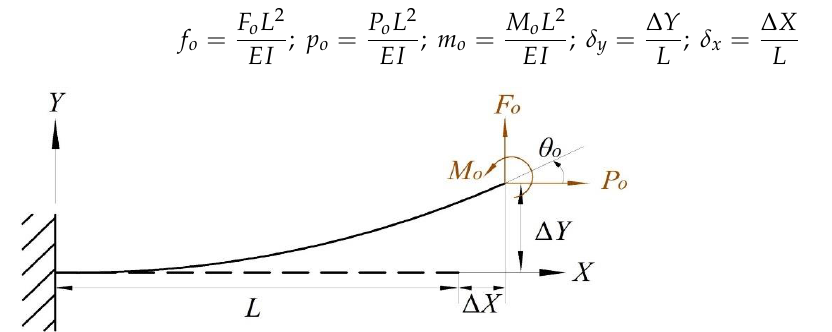
Figure 5. Typical beam with a planar flexible